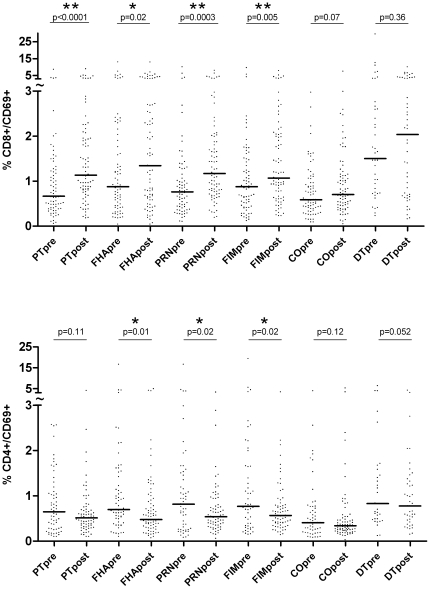
CD69+ antigen specific T cells after aP booster vaccination.Surface markers on T-lymphocytes were measured after 48 h of stimulation with pertussis antigens (PT, FHA, PRN, FIM), without antigen stimulation (CO), or with diphtheria/tetanus (DT) antigen stimulation. Immunophenotyping was performed prior to (pre) and 28–36 days after (post) aP booster vaccination. The percentages of CD8+CD69+
(a) and CD4+CD69+
(b) lymphocytes within the total lymphocyte population are shown for all participants. To show outliers, the y-axis was divided into two scales (tilde). Scatter blot; horizontal lines indicate the median value. * significant increase/decrease after vaccination (Wilcoxon-test; p<0.05). ** highly significant increase/decrease after vaccination (Wilcoxon-test; p<0.01).